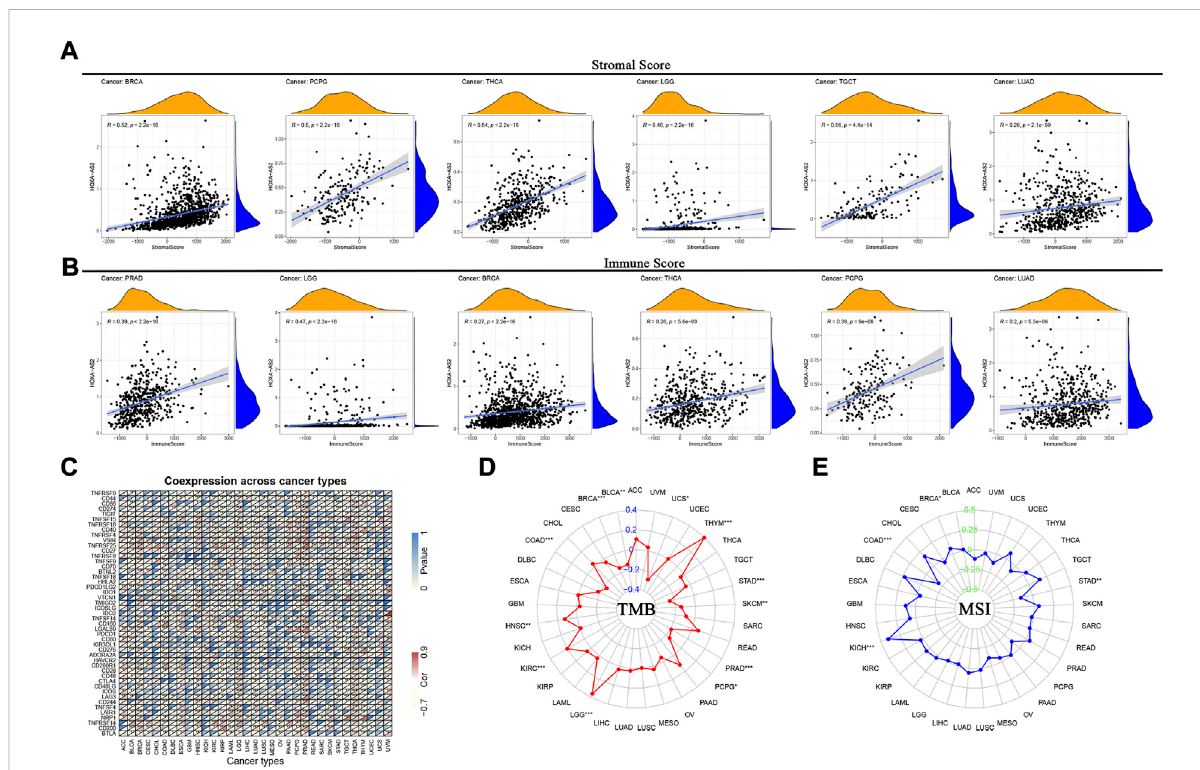
FIGURE 8 Correlations between HOXA-AS2 expression and immunity, including stromal score, immune score, immune checkpoint genes, TMB and MSI incancers. (A) CorrelationofHOXA-AS2expressionwiththestromalscoreinpan-cancer. (B) Correlation ofHOXA-AS2expressionwiththeimmune score in pan-cancer. (C) Correlation of HOXA-AS2 expression and immune checkpoint genes. (D) The radar chart displays the correlation of TMB with HOXA-AS2 expression. The red curve indicates the correlation coef fi cient, and the blue value indicates the range. (E) The radar chart displays the correlation of MSI with HOXA-AS2 expression. The blue curve indicates the correlation coef fi cient, and the green value indicates the range. * p < 0.05, ** p < 0.01, and *** p <